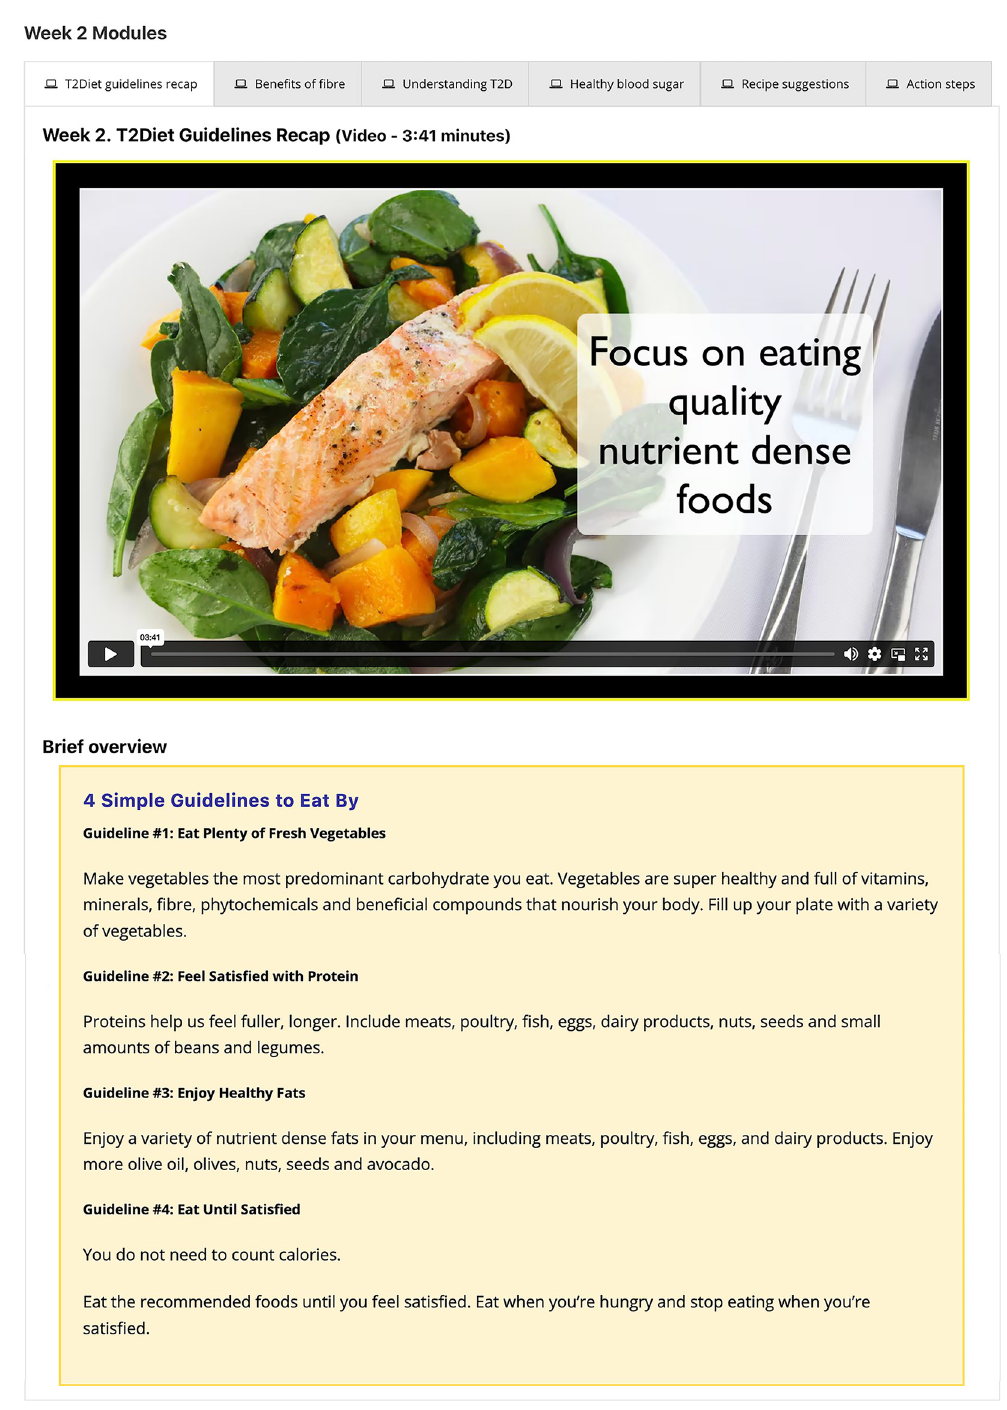
Fig 2. Example presentation of the weekly structured